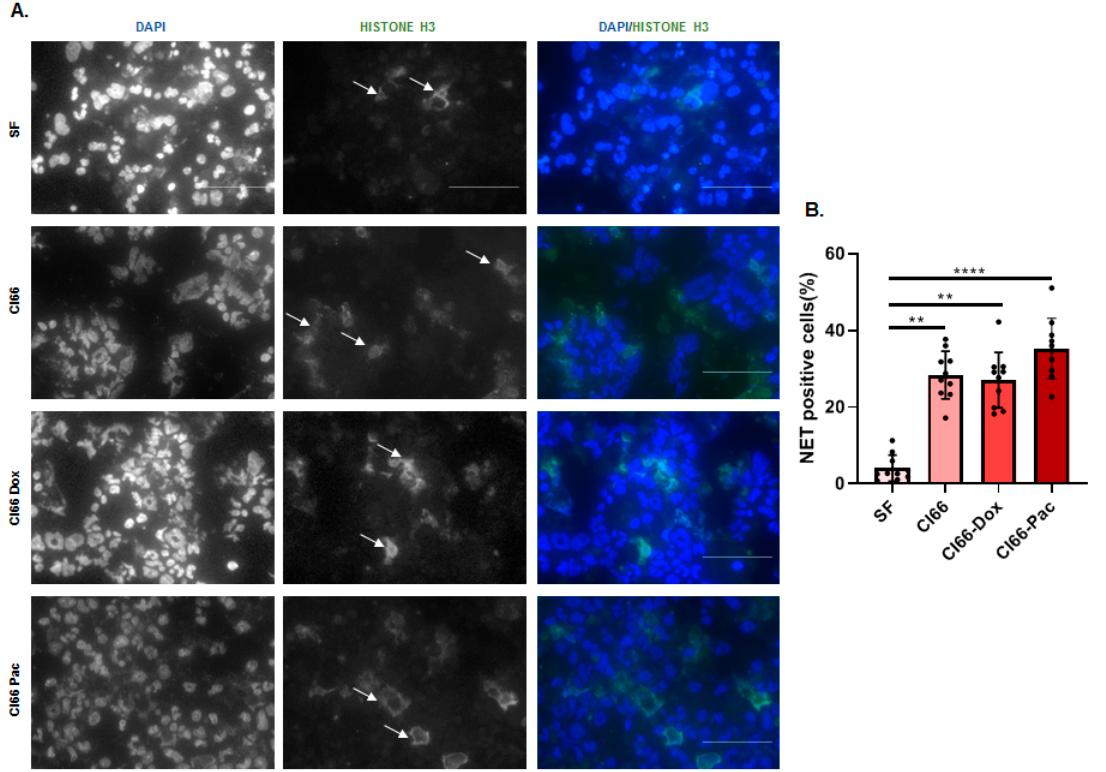
Figure 5. Breast cancer cells induce the formation of NETs. ( A ) Representative image showing the formation of NETs by MPRO cells in culture of the Cl66, Cl66-Dox, and Cl66-Pac cell lines in comparison with MPRO cells in SF media. The scale bar represents 100 μ m. ( B ) A bar graph showing the percentage of NET-producing MPRO cells per field following treatment with supernatants from parental Cl66, Cl66-Dox, and Cl66-Pac cells. The data are a representative of two independent experiments with similar results. ** p < 0.01; **** p ≤ 0.0001.